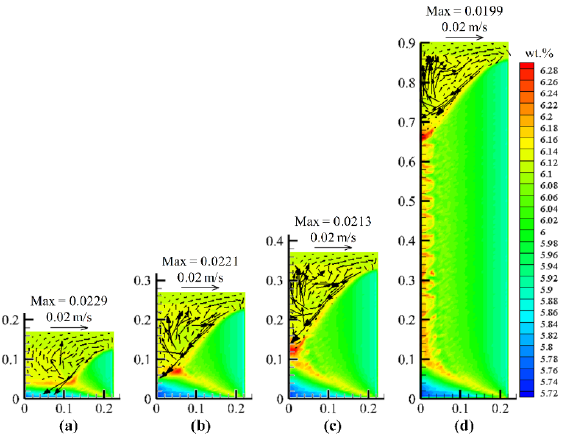
Figure 6. Evolutions of the flow field and macrosegregation predicted in the grain-refined billet (case 1): ( a ) 100 s, ( b ) 200 s, ( c ) 300 s, and ( d ) 830 s.